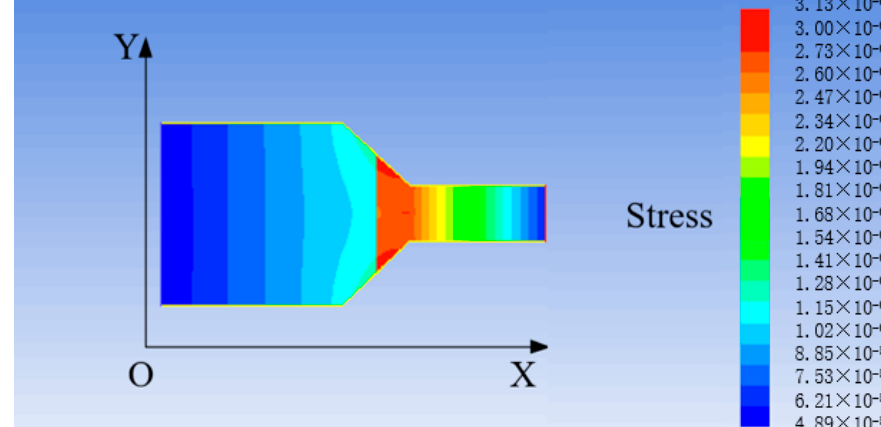
12 of 20 Figure 15. The stress of the water wheel (unit: MPa). According to the stress and strain diagrams of the water wheel, the connection be- tween the gear and the water wheel has obvious stress and large strain, and there is almost no stress on other parts of the water wheel. Considering the processing difficulty, the same material should be selected for the overall structure of the water turbine, especially the material with high strength and sensitive response. If the water wheel needs to be im- mersed in water for a long time, the material with excellent corrosion resistance should be selected. 3.2. Fluid–Solid Coupling Analysis of the Venturi in the Sensor The water flowing through the venturi has an impact on the venturi. If the impact force of the water flow is too large, the necking section of the venturi will be deformed. Thus, it is necessary to analyze the internal stress and strain of the venturi. The venturi has certain friction to the flow and reduces the flow velocity. Therefore, it is also necessary